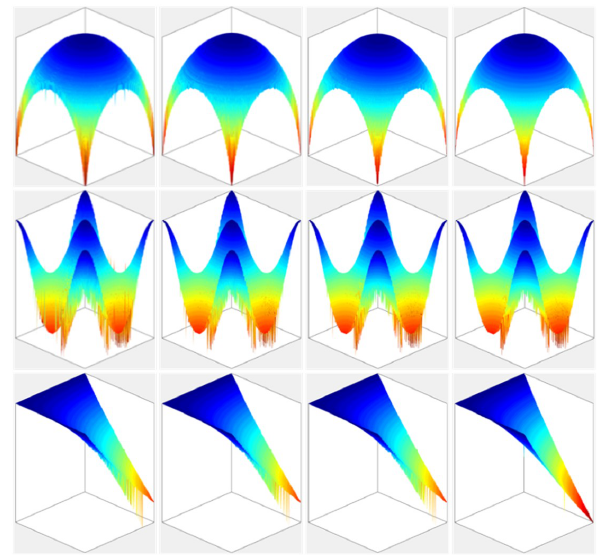
Figure 15. Initial depth map of the three models reconstructed using different evaluation windows of F SML.